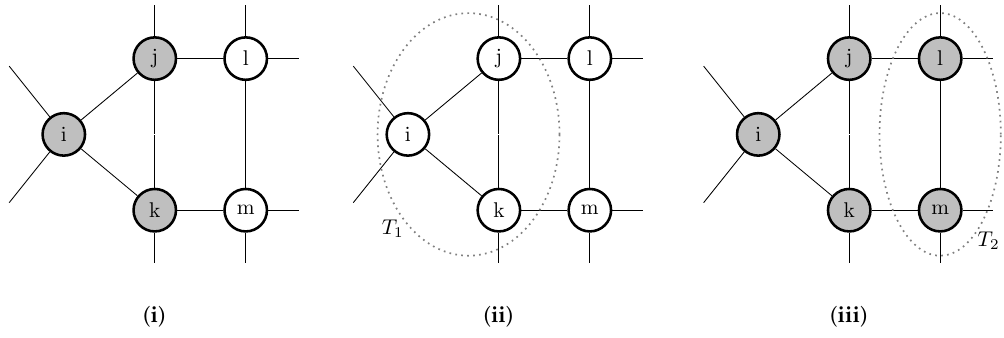
Figure 5. Conservative and reforming effects of collective agency. Grey vertices are playing strategy A , white vertices are playing B , as are all vertices not shown. Payoffs are given by the game in Figure 4ii. Panel ( i ): an initial strategy profile. Without coalitional behavior, it is not a best response for any player to change strategy as long as α < 2. Panel ( ii ): Conservative effect. From the profile in Panel (i), if α < 1, then all of the members of coalition T 1 gain by switching to B . Panel ( iii ): Reforming effect. From